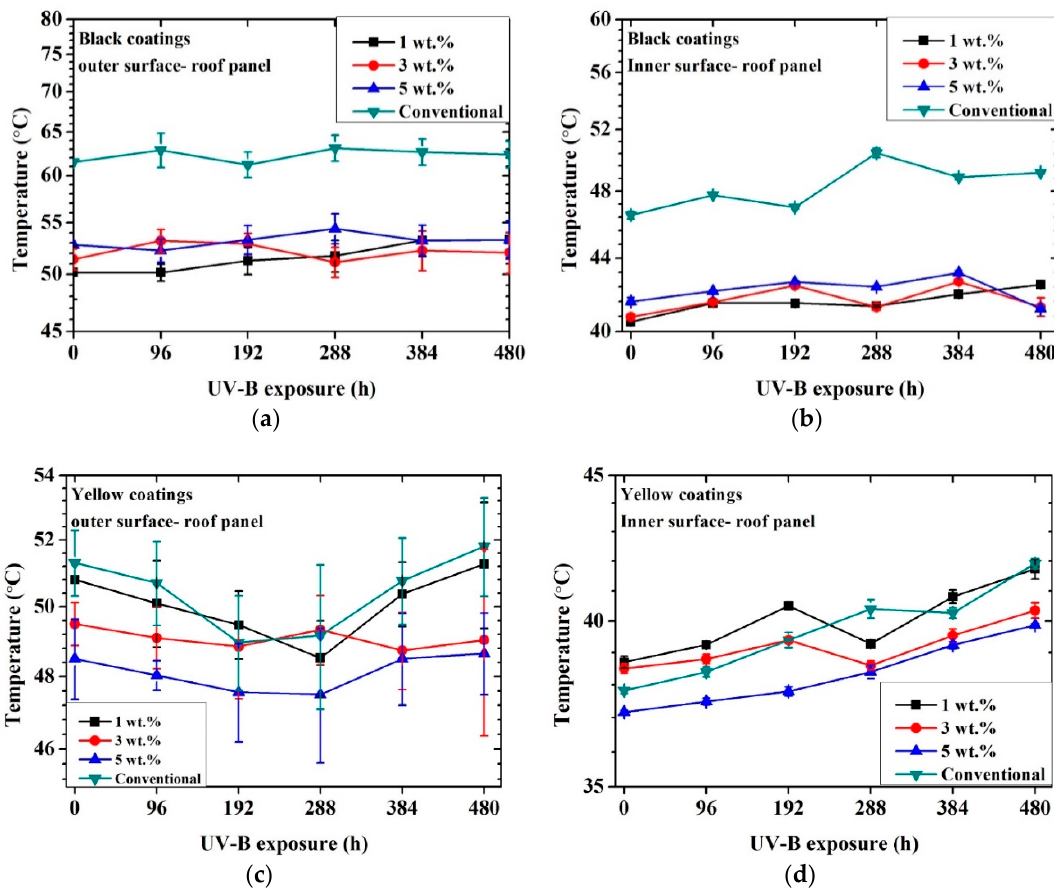
Figure 5. Temperature profile vs. time exposed to artificial UV-B light: black coatings outer surface of roof panel ( a ), black coatings inner surface of roof panel ( b ), yellow coatings outer surface of roof panel ( c ), yellow coatings inner surface of roof panel ( d ).